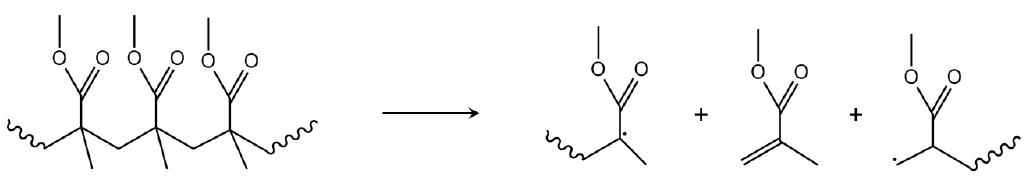
Figure 12. Alternative concerted pathway leading to initiation (so fifth mechanism) in the theoretical research of Stoliarov et al. [74].